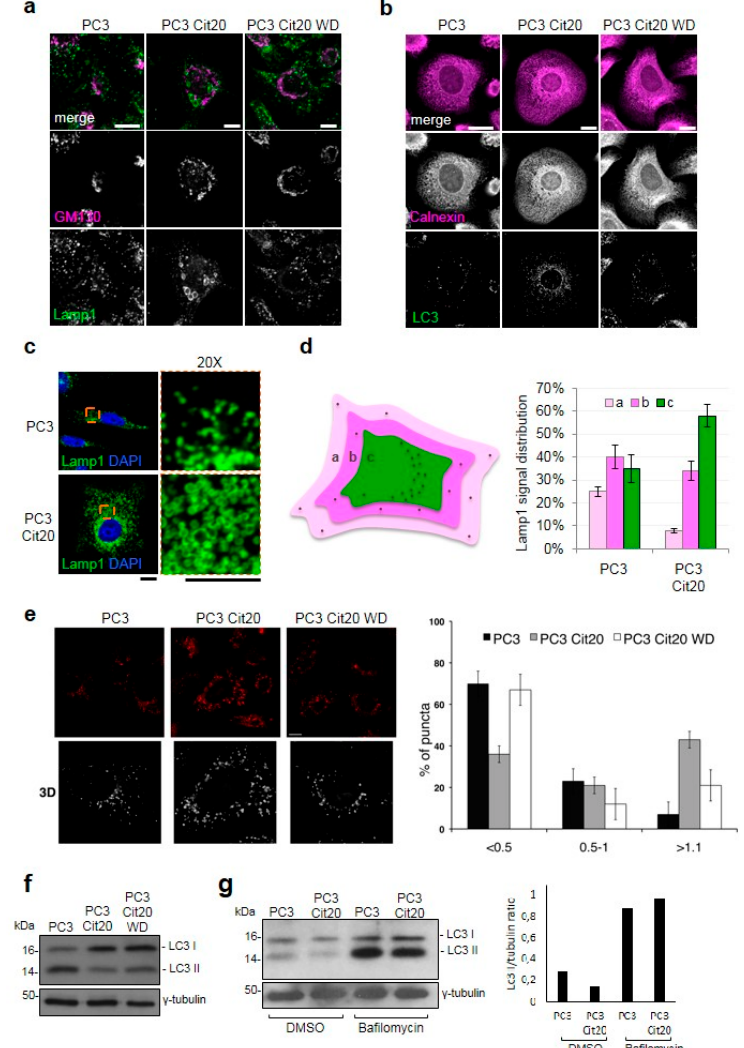
Figure 4. The morphology of Golgi complex and endolysosomal compartment is altered in citrate-resistant PC3 cells. Representative images of PC3, PC3 Cit20, or PC3 Cit20 WD cells labeled with different organelle markers (a-e) are shown. ( a,b ) PC3, PC3 Cit20, and PC3 Cit20 WD cells were grown on glass coverslips and subjected to indirect immunofluorescence by using the indicated antibodies to stain Golgi complex (GM130), lysosomal compartment (Lamp1), endoplasmic reticulum (Calnexin), and autophagosomes (LC3). A single focal section is shown. Scale bar: 10 µ m. ( c , d ) Lysosomal compartment and nuclei of PC3 and PC3 Cit20 cells were labeled by using a mouse monoclonal antibody against Lamp1 and DAPI, respectively. Magnifications (20 × ) are shown on the right. Scale bar: 10 µ m. In (d), lysosome distribution was analyzed as indicated in the scheme and quantified as reported in the histogram on the right. Data are expressed as mean ± S.D. of three independent experiments on a total of 90 cells. ( e ) For each condition, single Z-section (scale bar 10 µ m) and 3D reconstruction are shown. Quantification of lysosome size expressed as a percentage of total puncta is shown. Bars: mean ± S.D. ( f ) Western blot analysis of LC3-II protein levels was performed on total cell extracts of PC3, PC3 Cit20, and PC3 Cit20 WD cells. ( g ) As in (f), LC3-II protein levels were analyzed before and after bafilomycin A1 treatment (400 nM) and quantifications are shown in the histogram on the